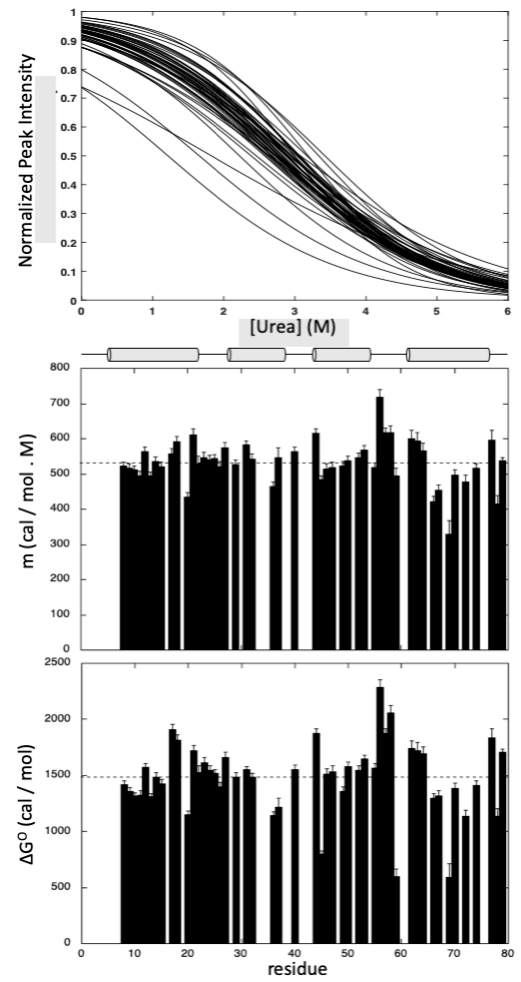
Figure 8. Steady-state thermodynamic parameters measured for GIPC1-GH2 at 20 °C from residue-specific urea denaturation curves. From top to bottom: overlay of the normalized residue-specific denaturation curves as obtained from the fit of the urea concentration-dependent sigmoidal decrease of the residue cross-peak intensities in the HSQC spectra with Equation (5); residue-specific values of the apparent m-values plotted versus the protein sequence; residue-specific values of the apparent free energy of unfolding ∆ G 0 u plotted versus the protein sequence. The dashed lines represent the mean values of the measured thermodynamic parameters. The location of the four helices in the protein sequence is schematized with cylinders on top of the graphics.